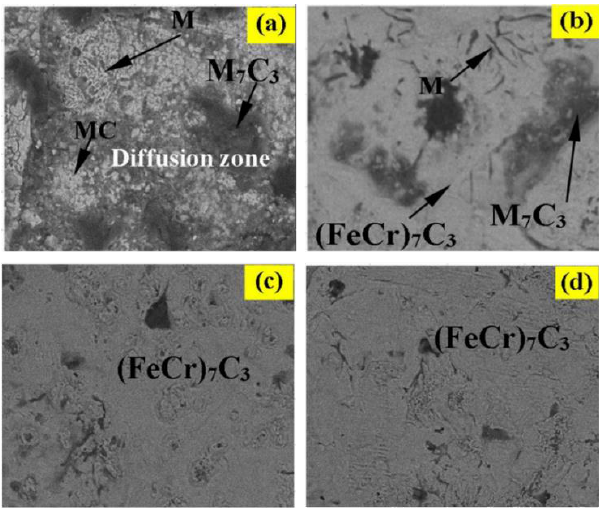
Figure 9: Energy Dispersive X-Ray (EDX) analysis to quantify the deposition of atom on the diffusion zone. (a) Sample